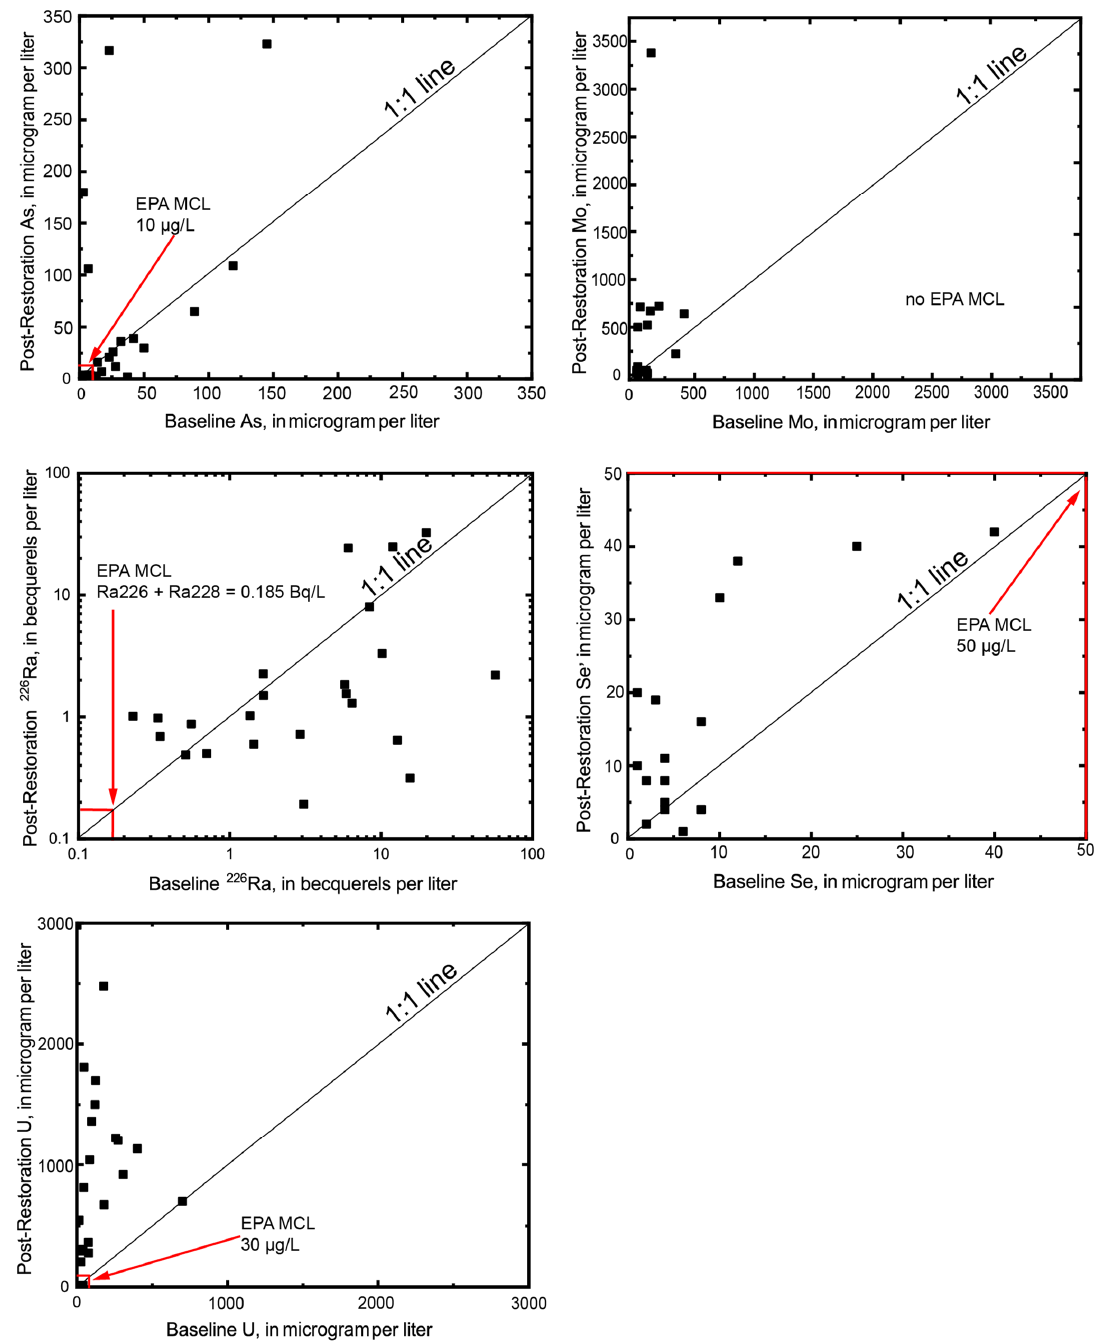
Figure 10. Graphs showing baseline As, Mo, U, and Se in milligrams per liter (mg/L), and 226 Ra concentrations in becquerels per liter (Bq/L) versus post-restoration concentrations. One to one lines and EPA maximum contaminant levels (MCLs) are shown [103]. Data from [104].